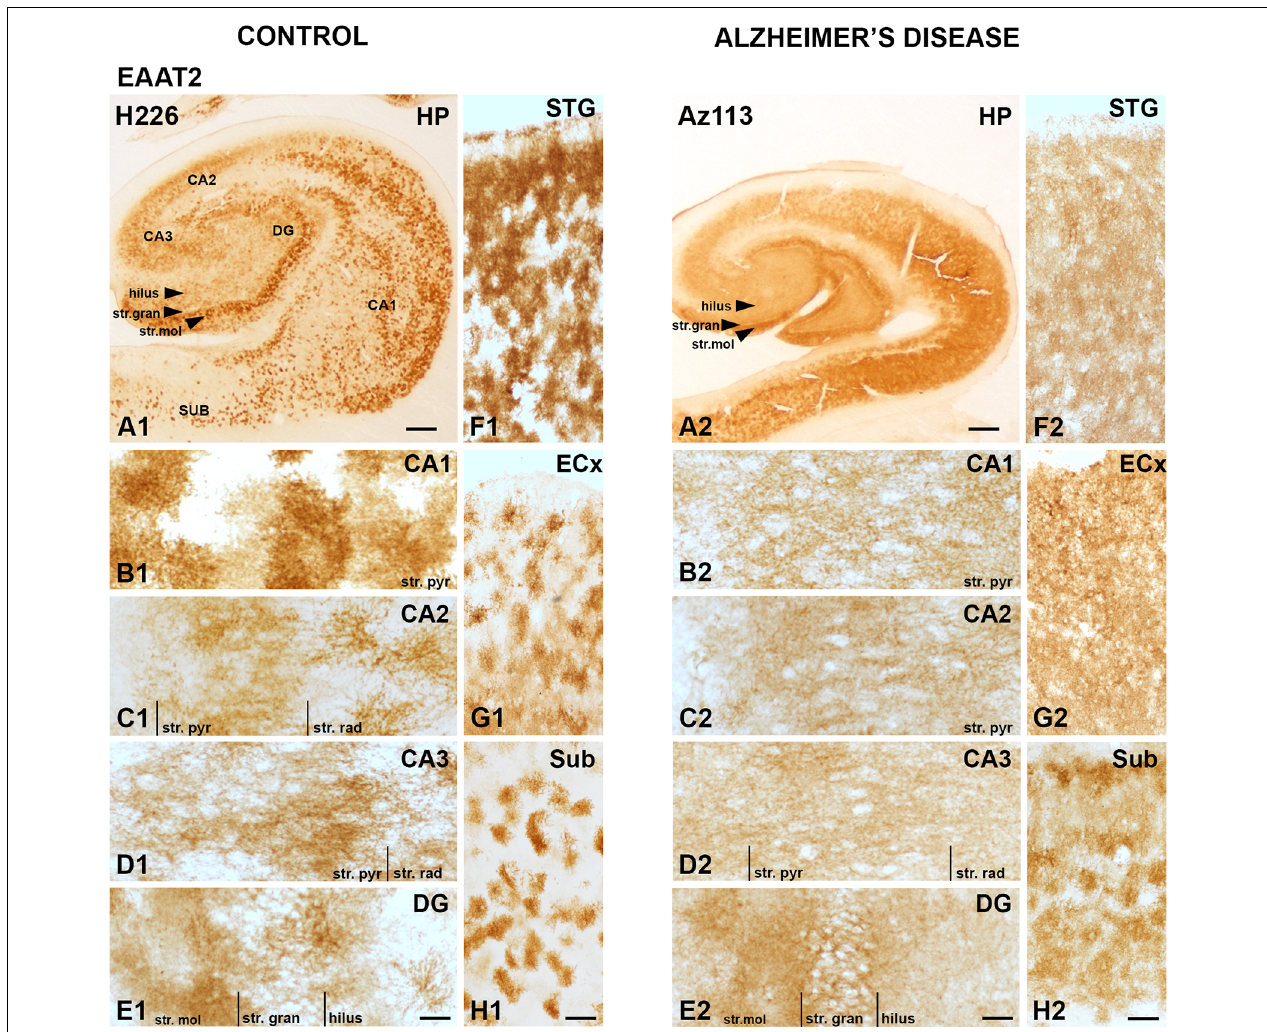
FIGURE 1 | EAAT2 expression in the hippocampus, subiculum, entorhinal cortex, and superior temporal gyrus in human control and Alzheimer’s disease (AD) cases visualized by 3,3 (cid:48) -diaminobenzidine-peroxidase immunohistochemistry. The EAAT2 staining is localized to astrocytes and appears relatively strong within the str. pyramidale of the CA1 subregion (A1,B1) , the stratum (str.) moleculare of the dentate gyrus (A1,E1) with more diffuse labeling in AD cases (A2–H2) . CA, cornu ammonis; DG, dentate gyrus; ECx, entorhinal cortex; HP, hippocampus; STG, superior temporal gyrus; str. pyr, stratum pyramidale; str. rad, stratum radiatum; str. gran, stratum granulosum; Sub, subiculum. Scale bars: (A1–A2) = 1,000 µ m; (B1–E1, B2–E2) = 100 µ m; (F1–H1, F2–H2) = 400 µ m.